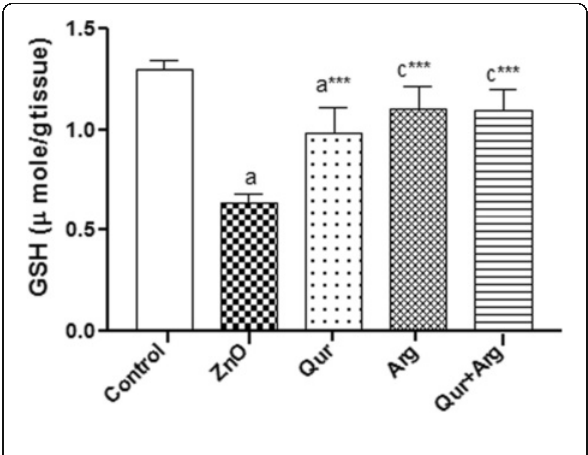
Figure 4 Effect of Qur and/or Arg treatment on renal glutathione level in intoxicated rats with a high dose of n-ZnO particles. Values are expressed as mean±S . D. a P < 0.001, c P < 0.05 compared with the normal control group, *** P < 0.001 compared with the n-ZnO-intoxicated group, respectively, using ANOVA followed by Bonferroni as a post-ANOVA test.